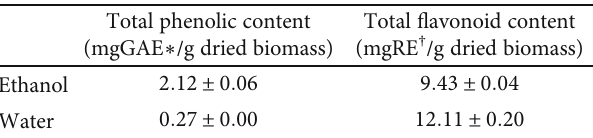
Table 1: Total phenolic and fl avonoid contents of P. serratifolia leaf